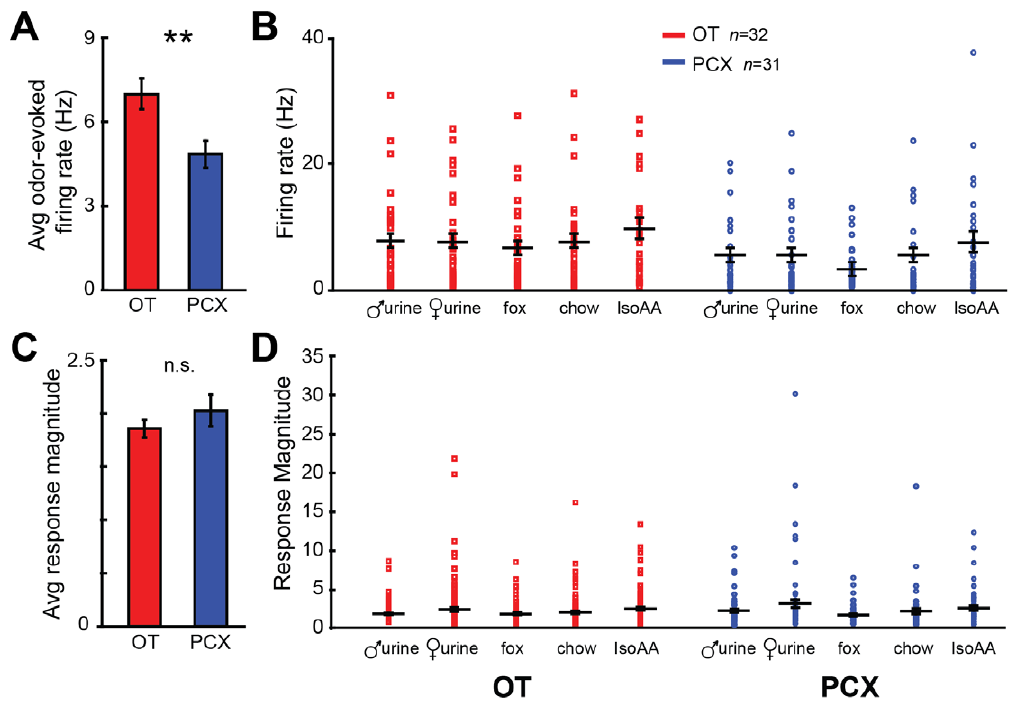
Figure 6. Odor-evoked spike rate, but not response magnitudes are greater in OT than PCX. ( A ) Average odor-evoked firing rate of OT (left) and PCX units (right). Data 6 SEM. ** p , 0.01, 2-tailed t -test. ( B ) Same rate data as in (A) but organized by odor. Each point represents average of 2 sec during odor, across . 4 trials/unit. Horizontal bars=firing rate average across units 6 SEM. ( C ) Average odor-evoked response magnitude (firing rate during odor as a proportion of that pre-odor) of OT and PCX units. Data 6 SEM. n.s.= p . 0.05, 2-tailed t -test. ( D ) Same magnitude data as in (C) but organized by odor. Each point represents average of 2 sec prior to odor, across . 4 trials/unit. Horizontal bars=average 6 SEM. doi:10.1371/journal.pone.0034926.g006 PLoS ONE |